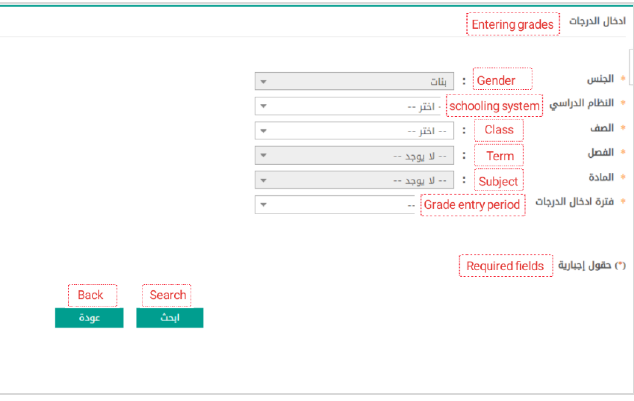
Figure 8. Entering grades task with an overlay translation in red.